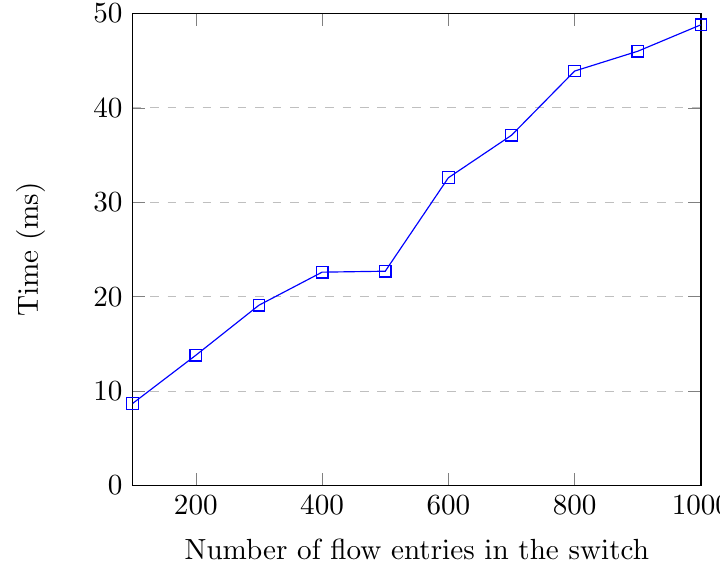
Figure 15. Feature retrieval time of 10 best features and classification time up to 1000 flow